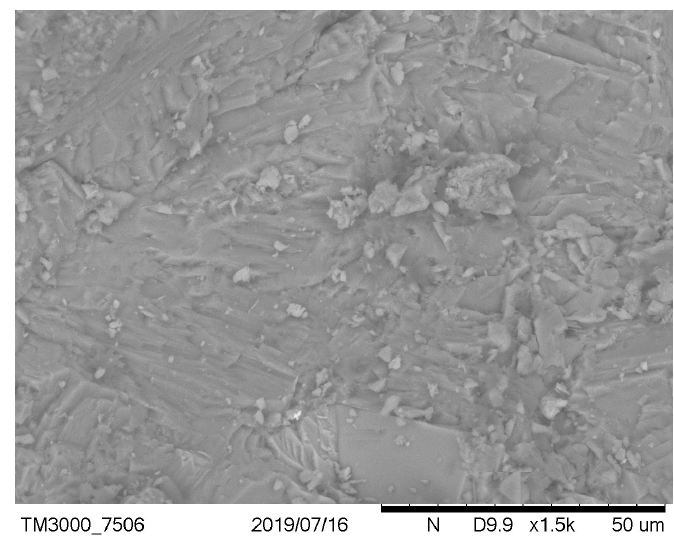
Figure 5. Carbonated concrete microstructure—mix symbol: 8, w / c = 0.38, p / c = 0.46.